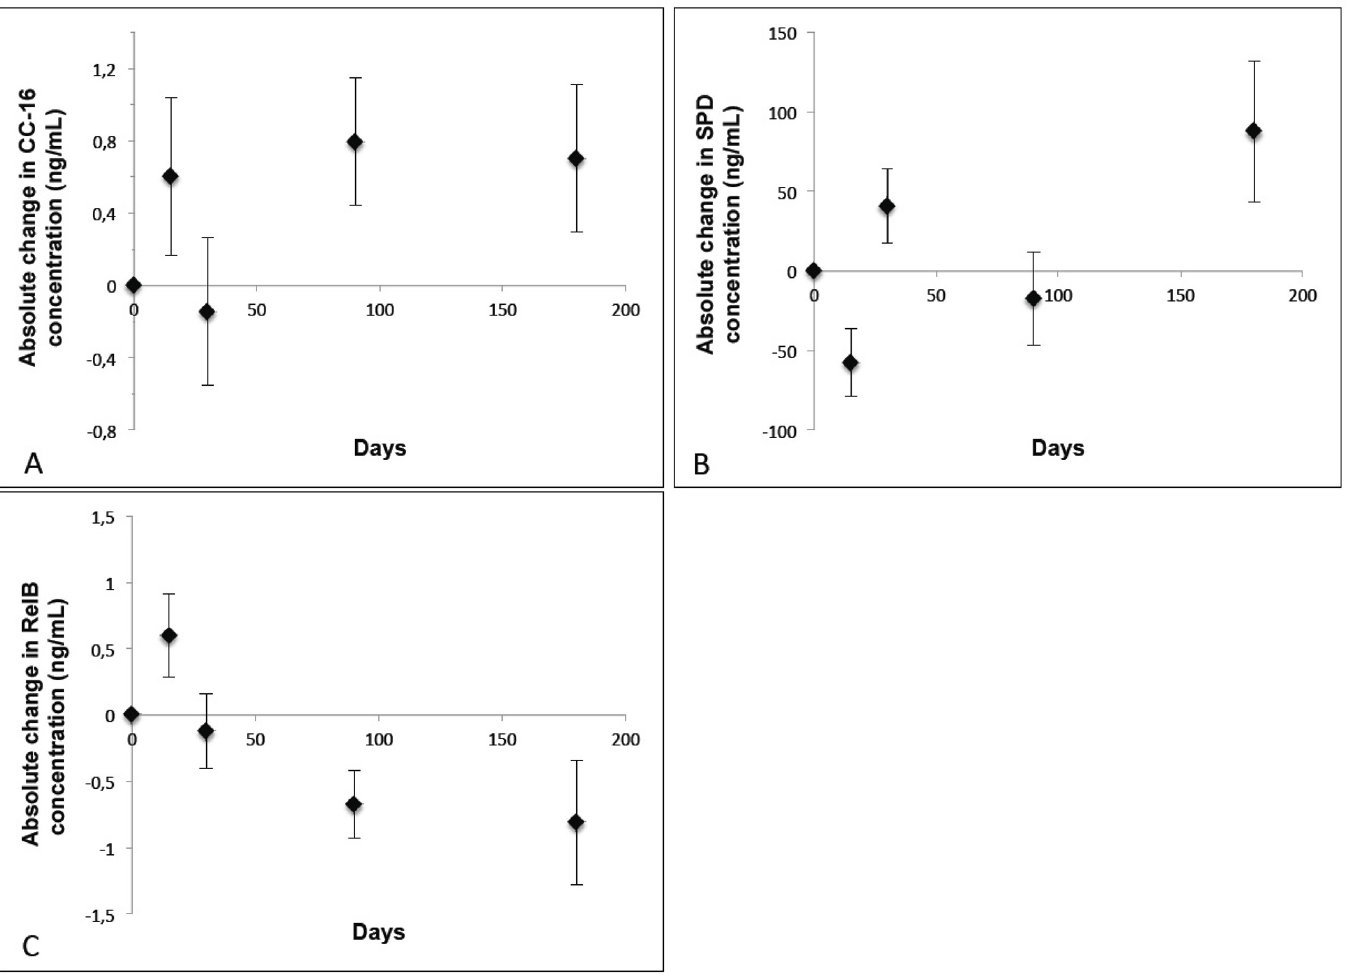
Fig 1. Mean absolute change in inflammatory mediators (ng/mL) ( ± standard error of the mean) over time. Panel A shows the course of change in CC- 16 over time compared to CC- 16 concentrations measured at initial assessment, panel B shows the course of change in SPD over time compared to SPD concentrations measured at initial assessment, and panel C shows the course of change in RelB over time compared to RelB concentrations measured at initial assessment. At day 15, concentrations of CC-16 and RelB were elevated compared to initial concentrations, whereas SPD concentrations were decreased. By day 30, both CC-16 and RelB were lower than initial levels but the level of SPD was increased. The directions of the absolute change in inflammatory mediators varied at the day 90 and 180 time points; all values were different from those at initial assessments.